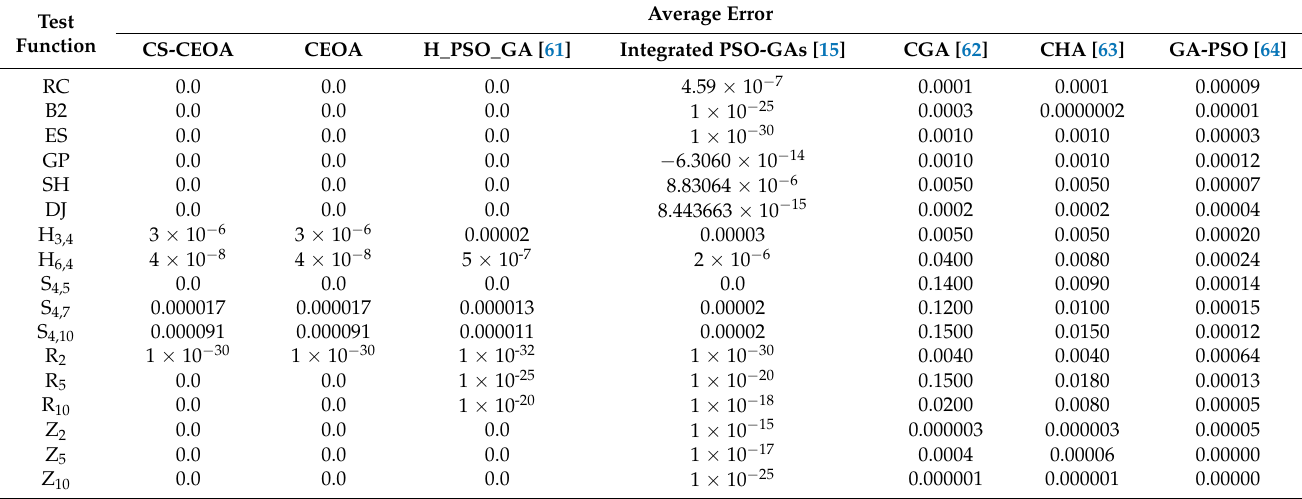
Table 3. Results provided by CS-CEOA, CEOA, H_PSO_GA, Integrated PSO-GAs, CGA, CHA and GA-PSO. Test Function